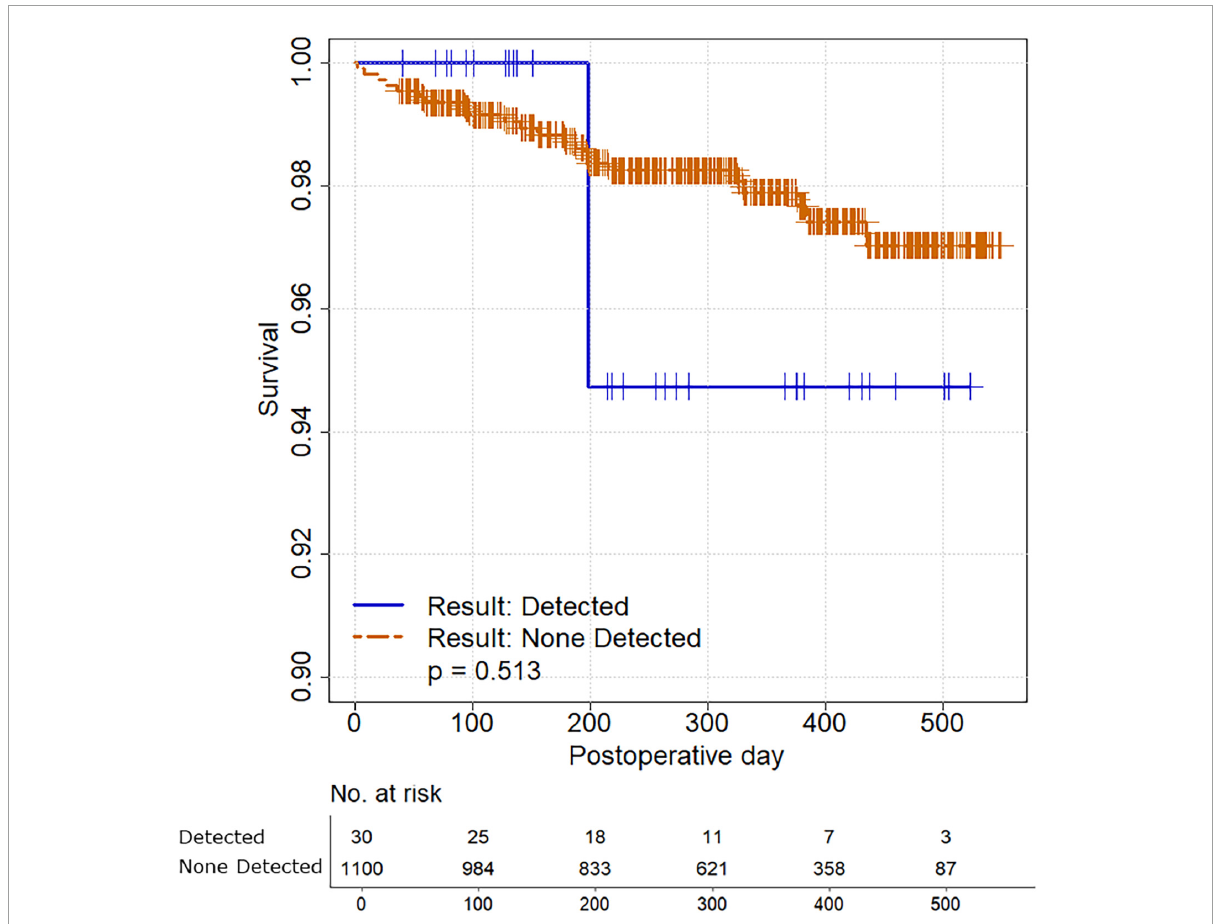
FIGURE1 Survival analysis comparing study participants with and without intraoperative detection of